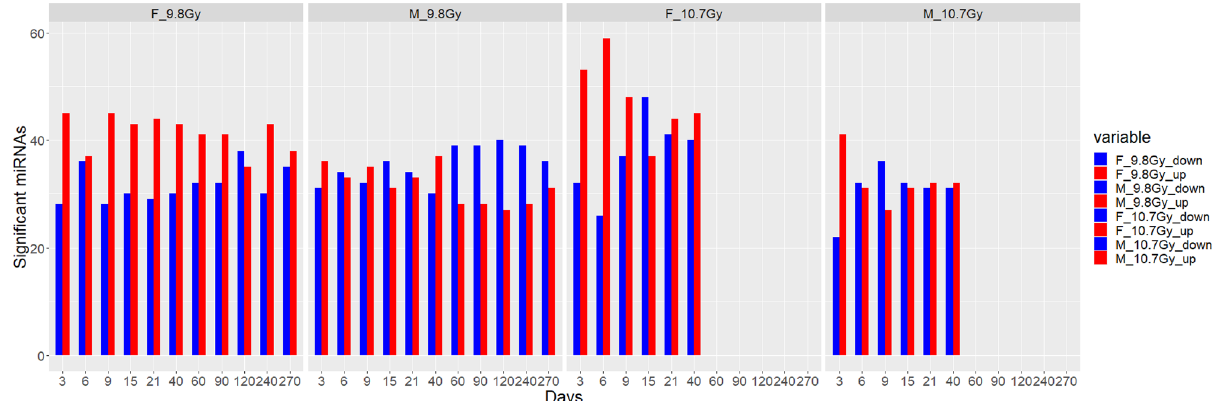
Figure 2. Number of significant miRNAs for each group and timepoint. Samples were separated based on sex and dose. Upregulation is indicated in red. Downregulation is indicated in blue. The significant expression of miRNAs varied over the 270-day course of the